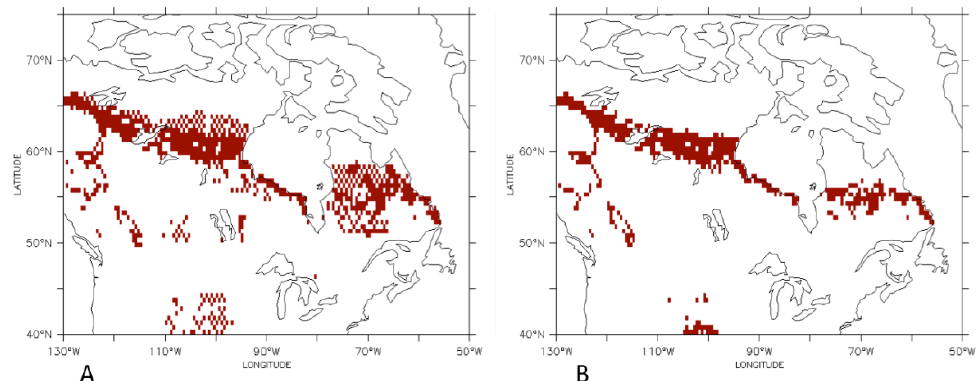
Figure 4. Maps of sites that contain biomass below the threshold of forest classification (in red) for directed ( A ) and even ( B ) dispersal at 0.1 km per year with a tripled disturbance rate.